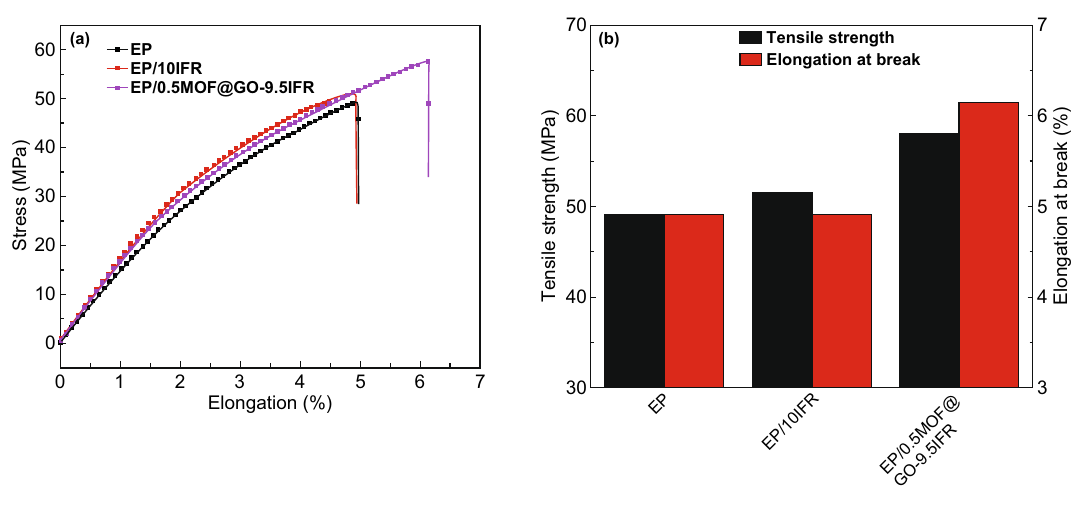
Fig. 17 The mechanical property of EP composites by tensile test. Reproduced from Ref. [81] with permission from